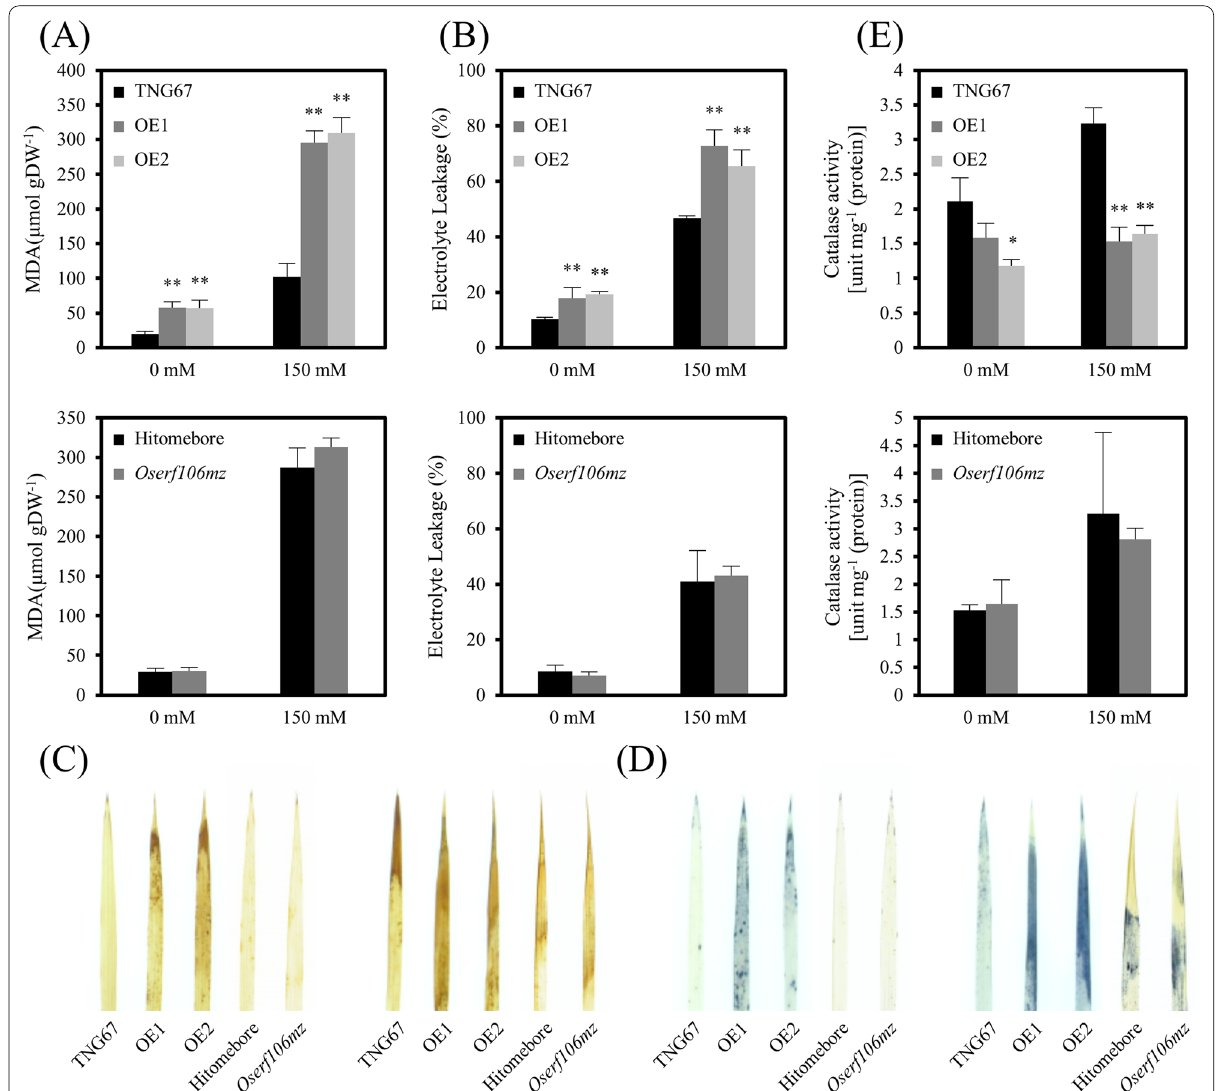
Fig. 4 Analysis of MDA content, electrolyte leakage, ROS levels, and CAT activity in the shoots of the OsERF106MZ ‑overexpressing transformants, Oserf106mz mutant, and the corresponding WT cultivars under normal and NaCl‑treated conditions. a MDA content. b Electrolyte leakage. c DAB staining. d NBT staining. e CAT activity. The values are the mean SE of five biological replicates, each with two technical replicates. Asterisks ± indicate significant differences (* P < 0.05 and ** P < 0.01) in comparison to the corresponding WT based on Student’s t ‑test. For these assays, seedlings were grown on basal medium for 7 days and then transferred to basal medium containing 0 or 150 mM NaCl for an additional